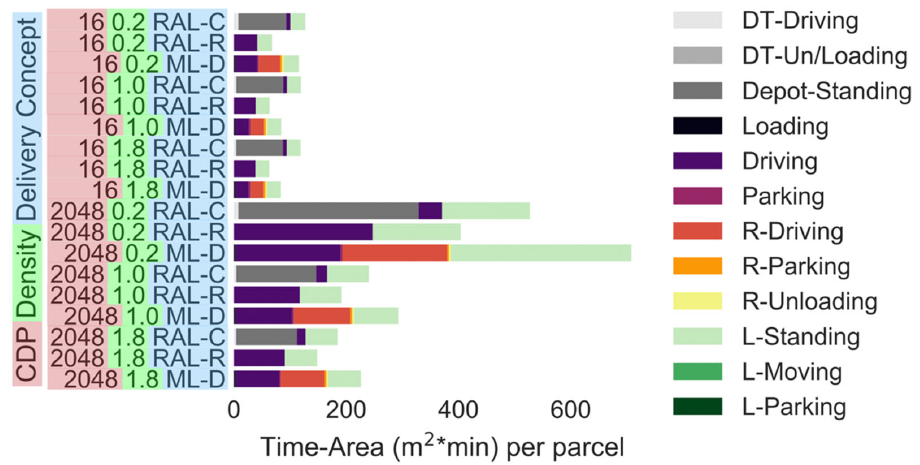
Figure 9. Time ‐ area requirements of RAL and ML ‐ D (number of CDPs: 16 or 2048). Parcel demand level: 0.2: 20% of the current demand, 1.0: current demand, 1.8: 80% increase in the demand.